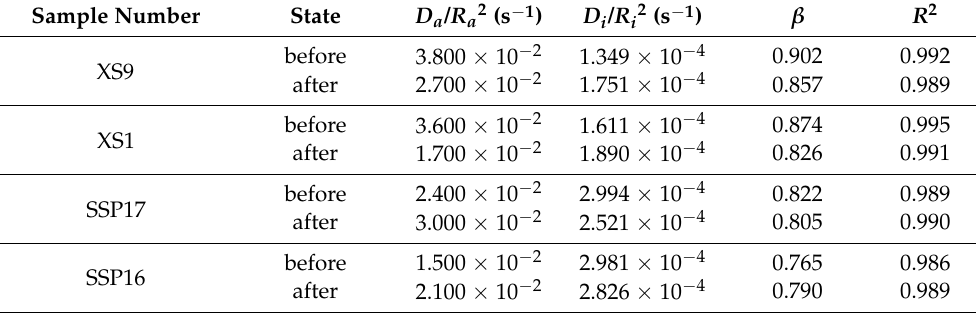
Table 3. Statistical results of CO 2 diffusion rate.